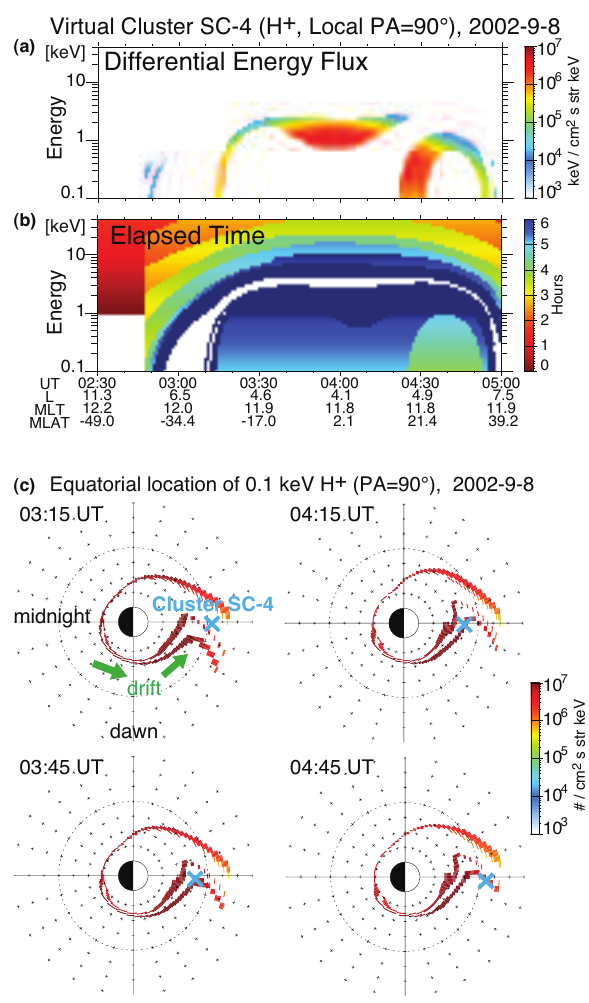
Fig. 5. The same as Fig. 3 but for the traversal on 8 September 2002. onsets, at around 16:40 UT, 18:30 UT, 22:50 UT, 01:20 UT and 05:10 UT. format as Fig. 3. For this simulation, protons are assumed to depart at the nightside outer boundary of 8 R E during two in- tervals: 20:00–21:00 UT and 22:00–23:00 UT, with a density of 0.5 cm − 3 and temperature of 50 eV, based on the back- ward tracing result of the observed protons. Figure 5a repro- duced two essential features of Fig. 1b: enhancement of the sub-keV ion population in the outbound, and the asymmet- ric energy–latitude dispersions with respect to the equator (increasing energy with time in both the inbound and out- bound). In addition, the simulation also reproduced the ion band at around 1–3 keV. This ion band has a different start time from the wedge-like dispersed ions, as shown in Fig.